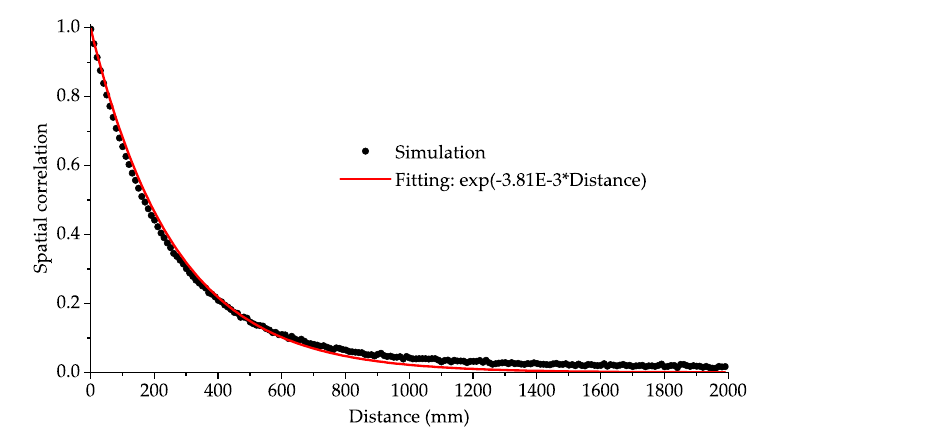
Figure 6. Spatial correlation of T i .